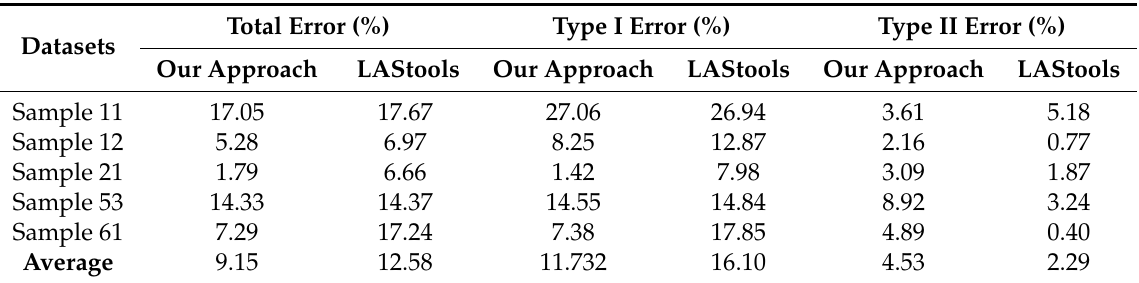
Table 5. A comparison between the full point cloud classification errors (lower is better) obtained by the naive method proposed and